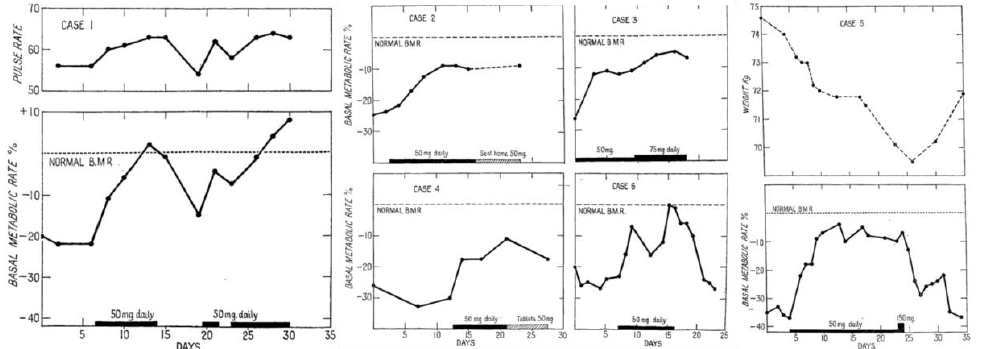
Figure 2. Changes in pulse-rate, basal metabolic rate, and body weight under oral treatment with 3,5-diiodothyronine (50 mg/d) of six hypothyroid individuals: Changes in pulse-rate, BMR and body weight under oral treatment with 3,5-T2 (50 mg/d) of six hypothyroid individuals. Case 1: Changes in pulse-rate and normalization of BMR under oral 3,5-T2 treatment (50 mg/d). Cases 2, 3, 4, 6: Restoration of BMR under oral 3,5-T2 treatment (initial dose: 50 mg/d). After initial daily treatment, case 2 was sent home for a week on an oral dose of 50 mg/d and then readmitted. Case 3 treated for 9 days with the initial dose of 50 mg/d and then the dose was increased to 75 mg/d for further seven days without any toxic symptoms. Case 4 received the initial daily oral 50 mg dose and after 10 days 3,5-T2 was administered as a pill on lactose base (25 mg) twice daily after food. Case 6 received the oral 50 mg/d dose restoring the BMR. Within four days of the drug being discontinued, her weight began to increase again and the pulse rate to fall (not shown). Case 5: Weight loss and restoration of regular BMR after 50 mg/d dose. The periods of oral 3,5-T2 treatment are indicated by black bars on the baseline, the switch to tablets in Case 4, and the ambulatory treatment in case 2 by shaded bars. Reprinted from The Lancet, Ref. [8] © 1933, with permission from Elsevier. Gemill et al. suggested that T4 and 3,5-T2 generate free radicals which interfere with ascorbic acid oxidation. This biochemical reaction was used as in vitro model to study the metabolic action of T4 [13]. Thermogenic and anti-goitrogenic effects of 3,5-T2 in rats were